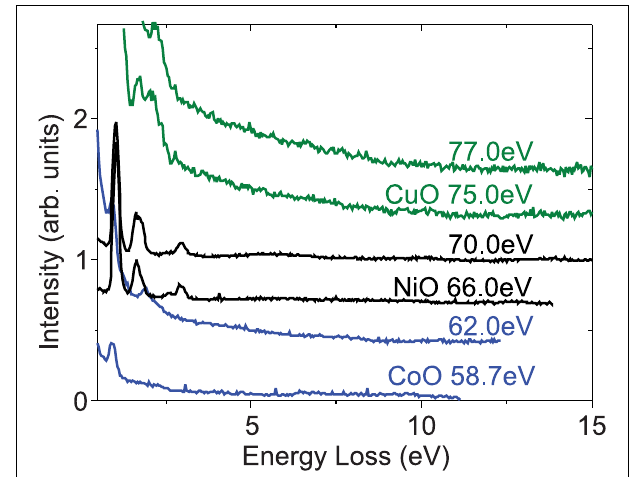
FIGURE 6 | No features at large energy loss. RIXS spectra are extended to large energy loss at incident energies that correspond roughly to the two principle inelastic resonance maxima for CuO, NiO, and CoO. Small fluctuations near the statistical noise threshold at large energy loss ( E & 5eV ) should not be analyzed quantitatively, as they tend to come from multiple reflection of the elastic line off of the analyzer vacuum